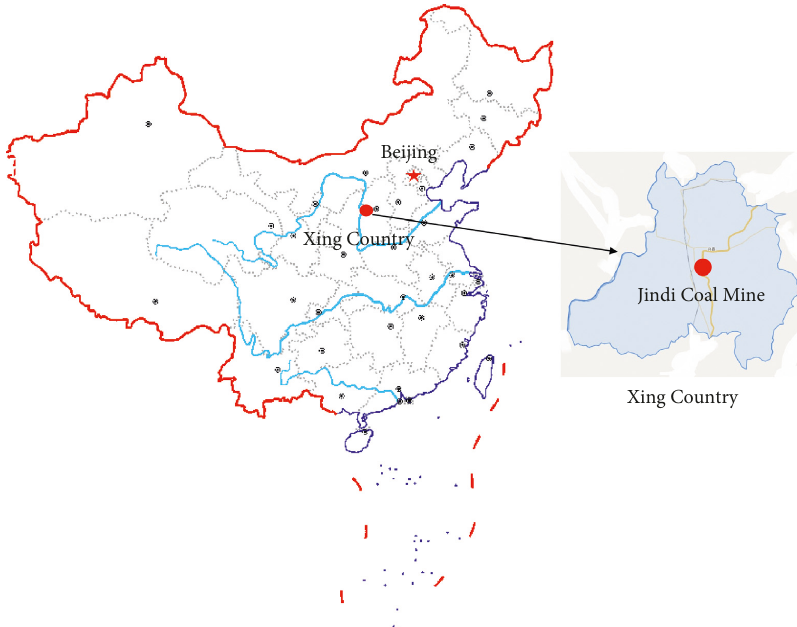
Figure 1: The geographic location of Jindi Coal Mine.